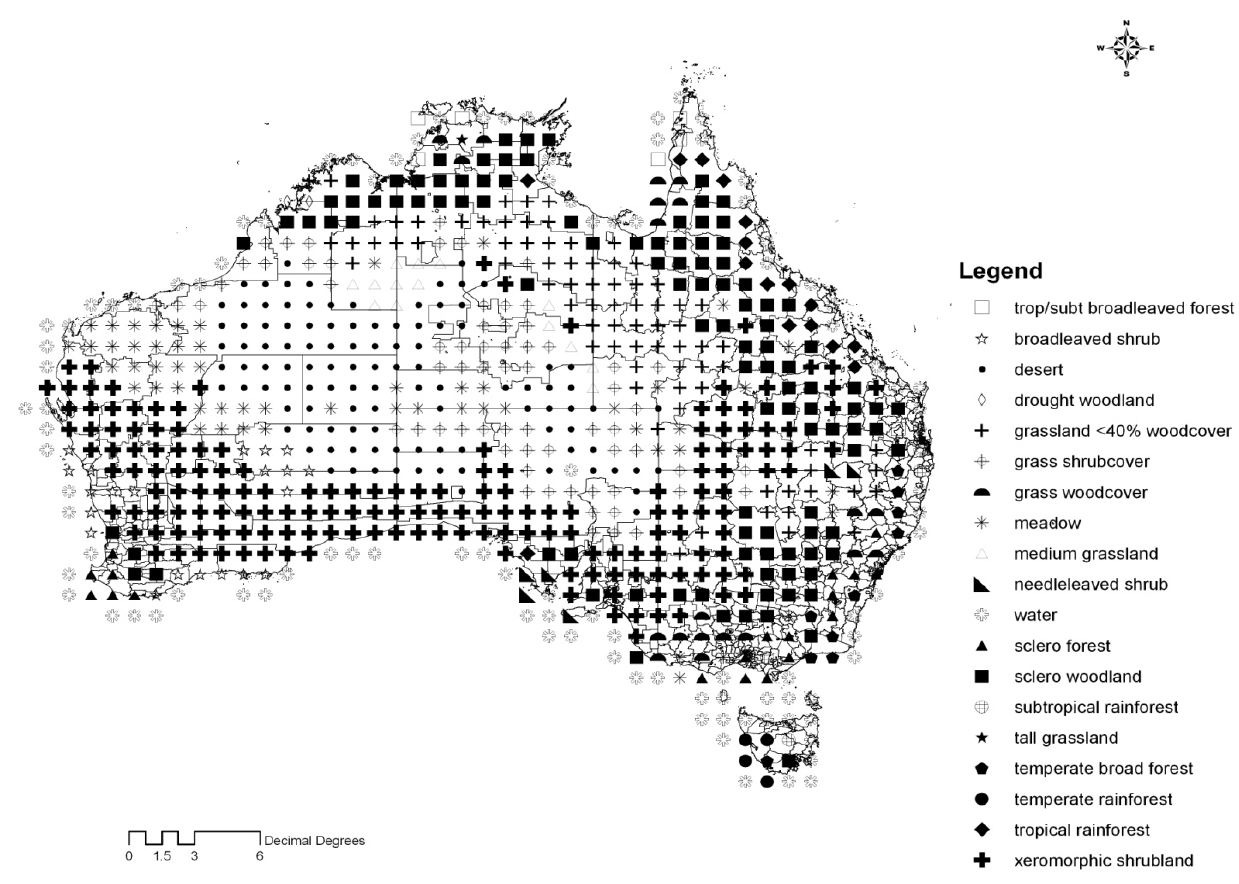
Figure 1. Major land covers in